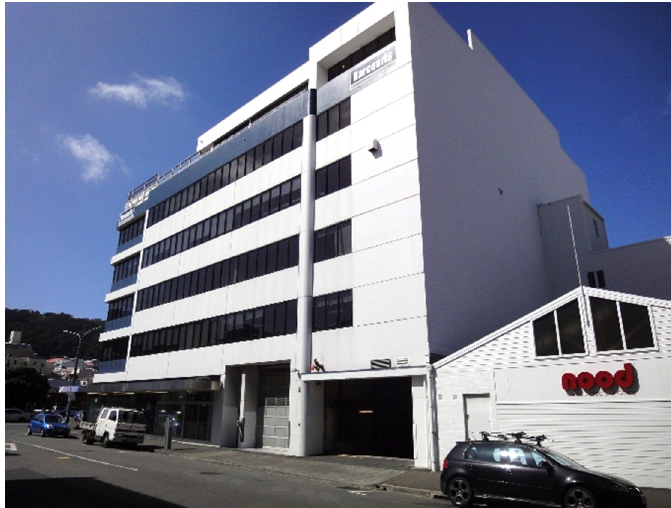
Figure 4. This large commercial building dating to the 1980s is the second least liked building in College Street.